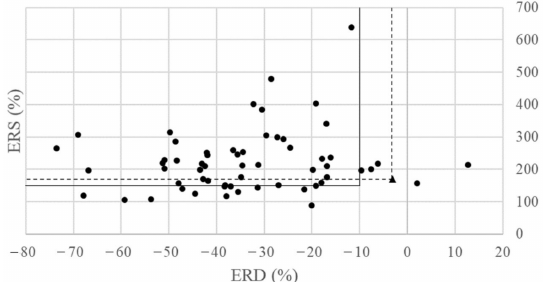
Figure 6. Plot of ERD ratio of change ( x -axis) vs. ERS ratio of change ( y -axis) derived from ICA_n10. Dotted lines indicate ERD/ERS criteria as set by session 31 (triangle). Solid lines indicate the criteria for ERD < − 10% and ERS > 150%. The number that satisfies these criteria is the number of points in the upper-left section as demarcated by the respective